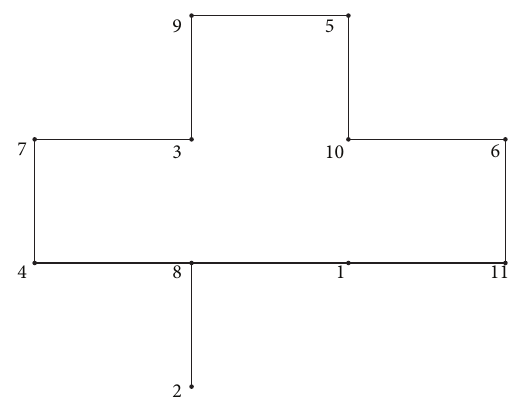
Figure 1: Uniform square mesh of five-point difference.